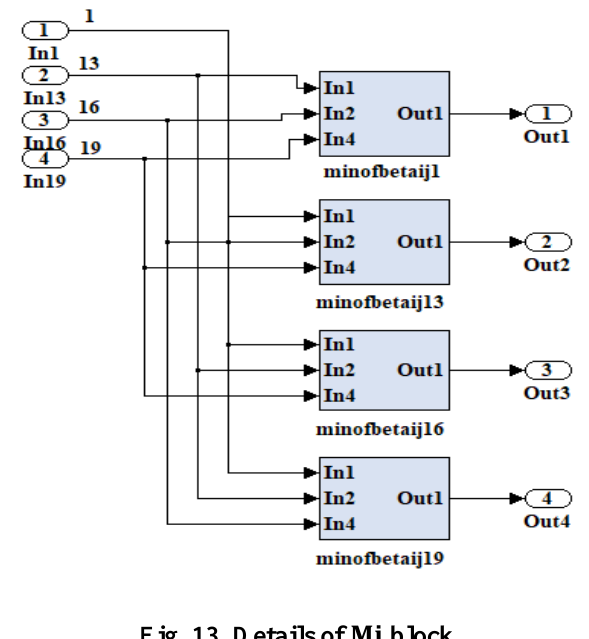
Fig. 13. Details of block.